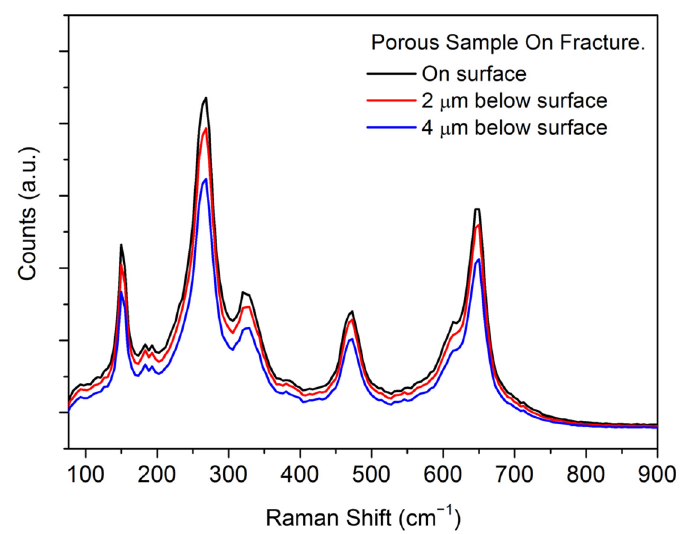
Figure 7. Raman spectra of a 47% porous sample, obtained with a confocal apparatus with ×50, 0.8 NA objective. At the surface (black line) and stage shifted 2 microns (red line) and 4 microns depth (blue line) into the sample.